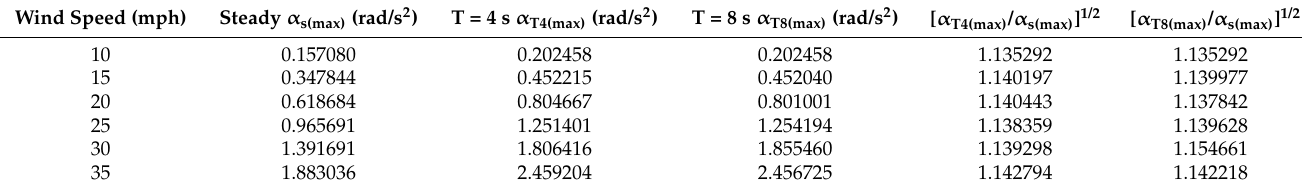
Table 3. The ratios between the angular accelerations of the rotor driven by steady and periodic winds. Wind Speed (mph) Steady α s(max) (rad/s 2